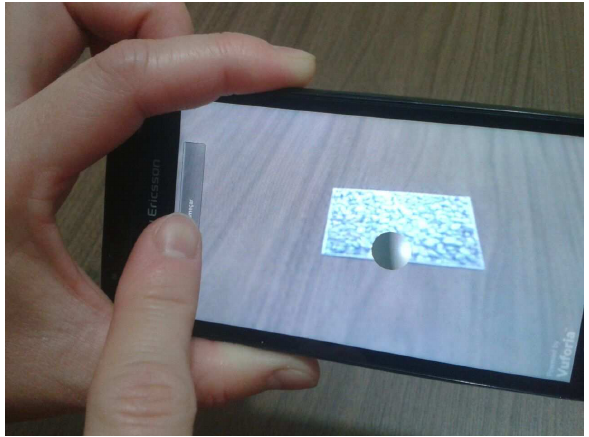
Figure 2. Scene of the application on one of the devices used in our experiments.